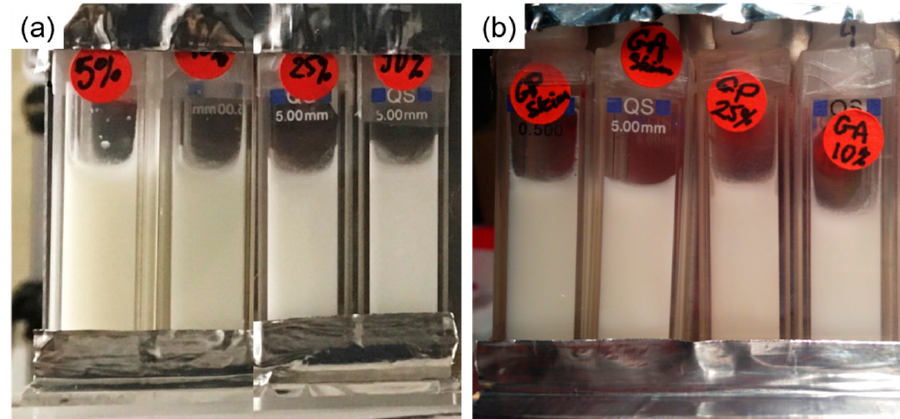
Figure 1. The deuterated milk samples. ( a ) Diluted milk powders in D 2 O solvent and ( b ) milk gels manufactured from diluted milk powders by acidification (marked “GA”) and rennet-induction (marked “GP”).